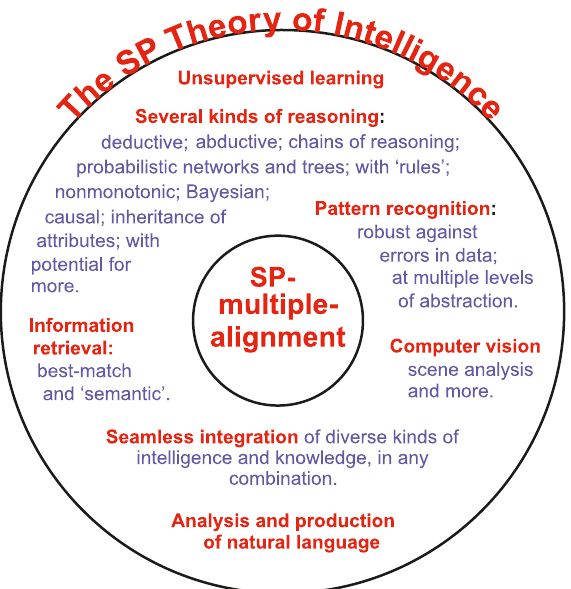
Figure 4: A schematic representation of versatility and integration in the SP System, with SP-multiple-alignment at centre stage (adapted from Figure 6 in [6], with permission).